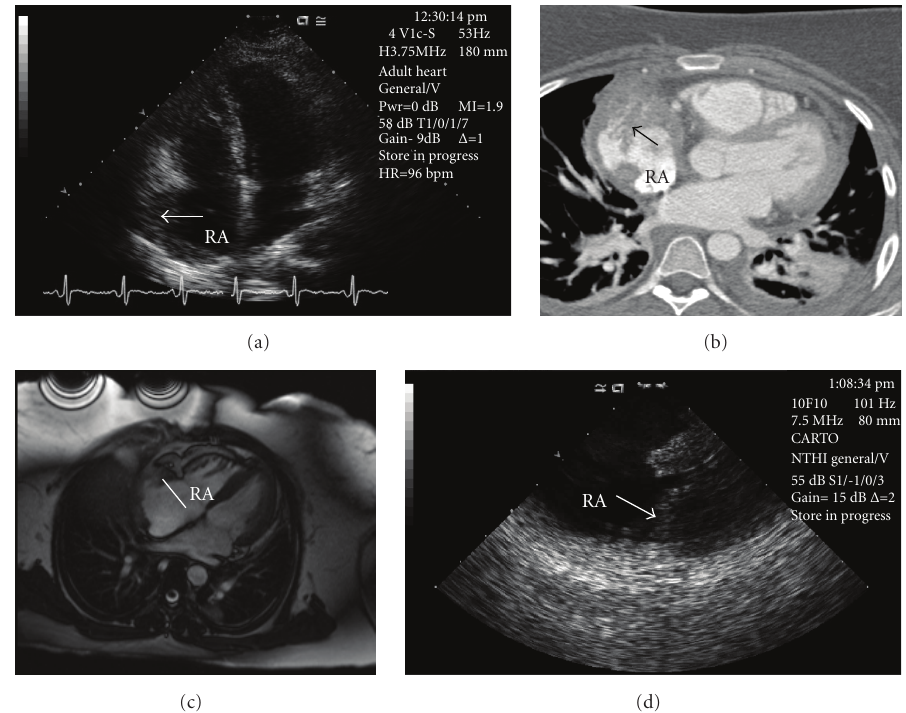
Figure 1: Right atrial mass imaging by di ff erent modalities: (a) Transthoracic echocardiography, apical four-chamber view. Thickening of the right atrial wall (arrow). (b) Chest CT, axial view. Enhancing mass (arrow) with papillary projections in the lateral wall of the right atrium. (c) Cardiac MRI, axial view. A heterogeneous, vascular mass involving the right atrial lateral wall. (d) Intracardiac echocardiography. Irregular mass (arrow) infiltrating the right atrial wall.